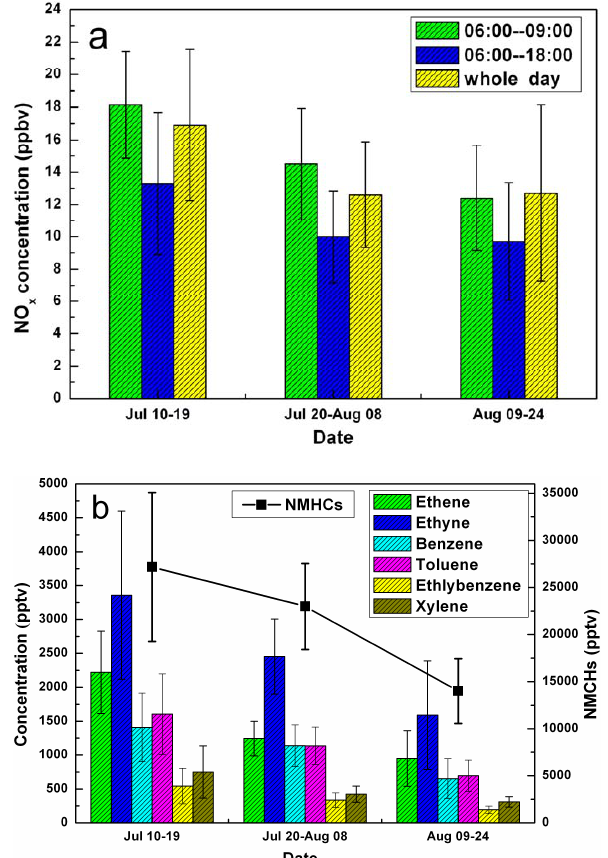
Fig. 4. Mean concentration of vehicle-related primary pollutants during the three periods at CRAES (a) NO x during rush hours, day- Figure 4. Mean concentration of vehicle-related primary pollutants during the three time and whole day and (b) individual and total C 2 -C 8 NMHCs. periods at CRAES (a) NO x during rush hours, daytime and whole day and (b) individual Vertical bars are half standard deviations. The number of VOC sam- ples is 6, 14, 14 for period 1, 2, and 3, and total C 2 -C 8 NMHCs. Vertical bars are half standard deviations. The number of VOC samples is 6, 14, 14 for period 1, 2, and 3, respectively.